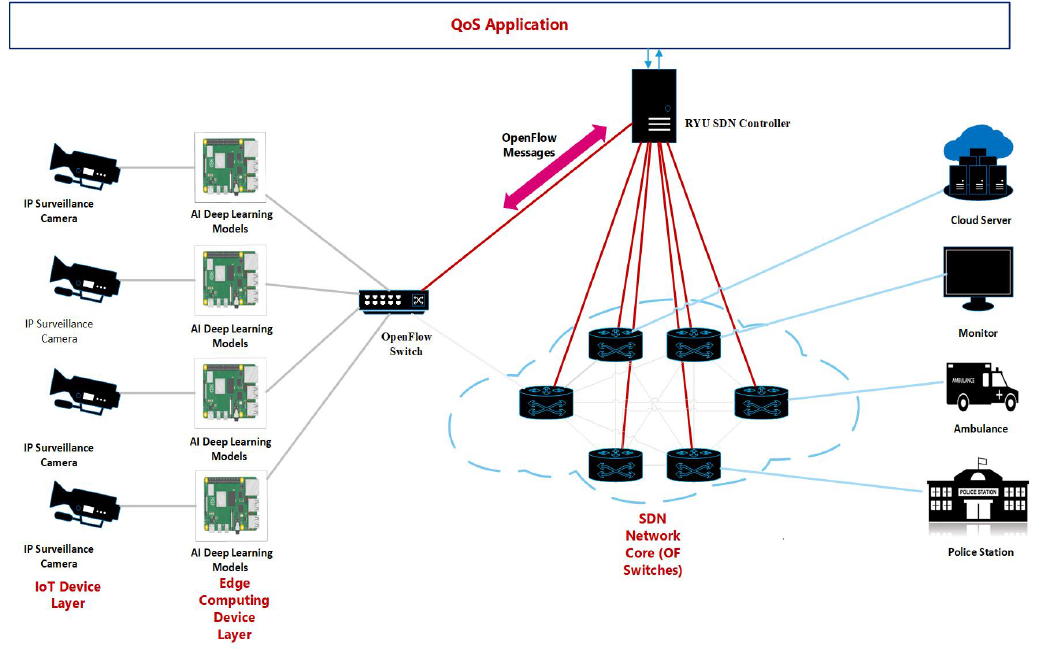
Figure 1. Proposed model